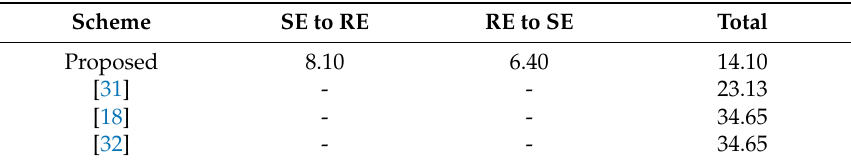
Table 2. The comparison in computational cost (msec).